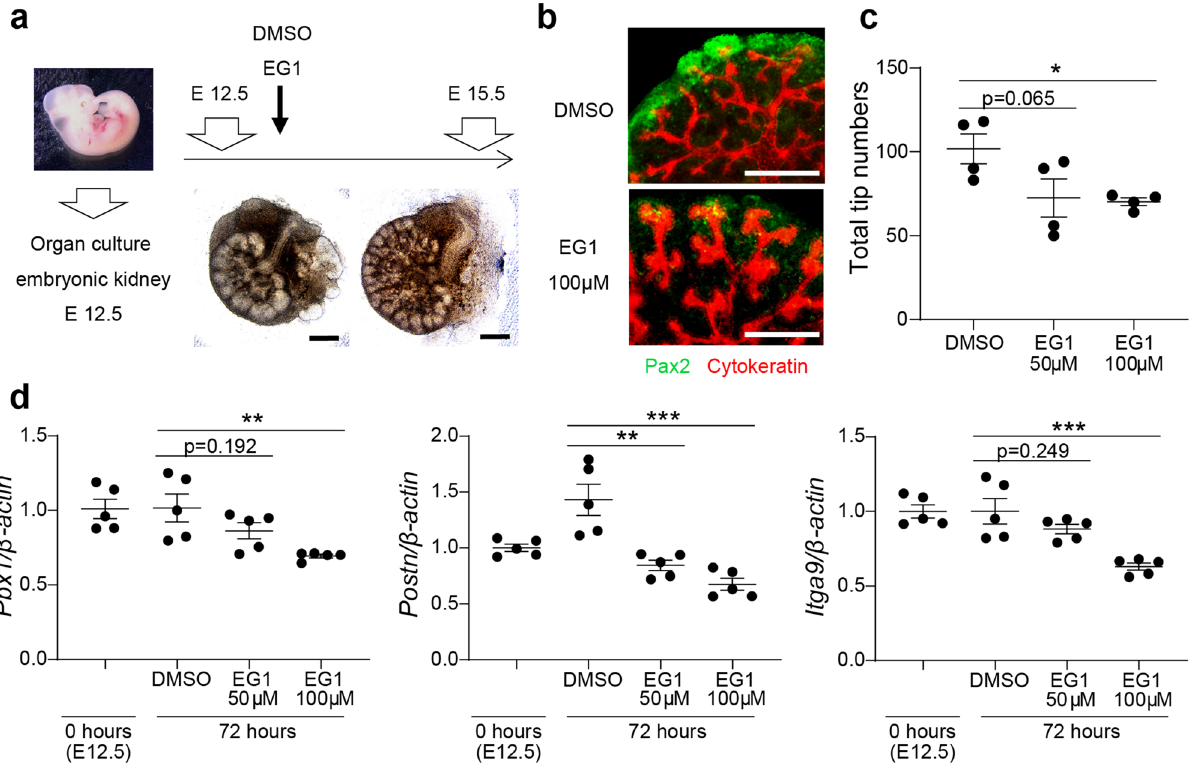
Figure 6. Verification of candidate PAX2 -regulated kidney development genes in a mouse model. ( a ) Protocol for organ culture using mouse embryonic kidney. Scale bars represent 300 μm. ( b ) Immunocytochemistry of organ culture using mouse embryonic kidney. Scale bars represent 300 μm. ( c ) Total numbers of ureteric tips in organ culture using mouse embryo kidney. Data are expressed as mean ± SEM, n = 4 per group. One-way ANOVA with post hoc Dunnett’s multiple comparisons tests, * P < 0.05. ( d ) mRNA expression levels of candidate PAX2 -regulated kidney development genes in organ culture using mouse embryonic kidney by quantitative reverse transcription-polymerase chain reaction (qRT-PCR). Data are expressed as mean ± SEM, n = 5 per group. One-way ANOVA with post hoc Dunnett’s multiple comparisons test, ** P < 0.01; *** P < 0.001. EG1, PAX2